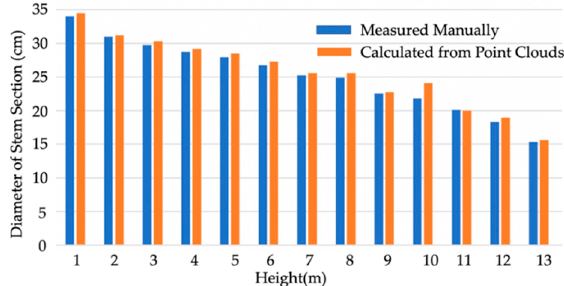
Figure 18. Diameters of stem sections of a sample tree.